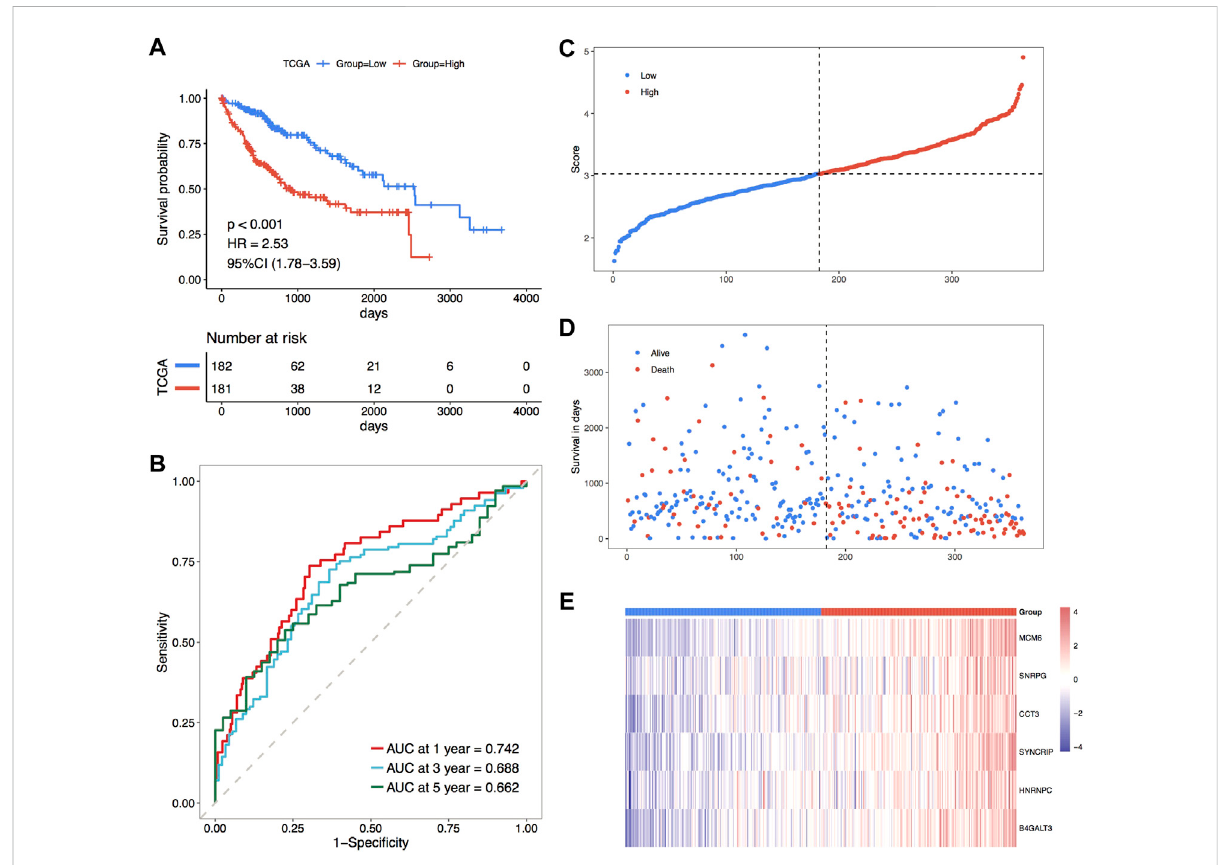
FIGURE 6 Prognostic ef fi cacy of TCGA holistic set validation model. (A) KM curves of TCGA holistic set; (B) ROC curves of TCGA holistic set at 1, 3 and 5 years; (C – E) risktriple-plotplotswithriskscorescatterplot,survivaltimescatterplotandheatplotofmodelgeneexpressioninriskscoregrouping, red highlights the high-risk group and blue highlights the low-risk group,